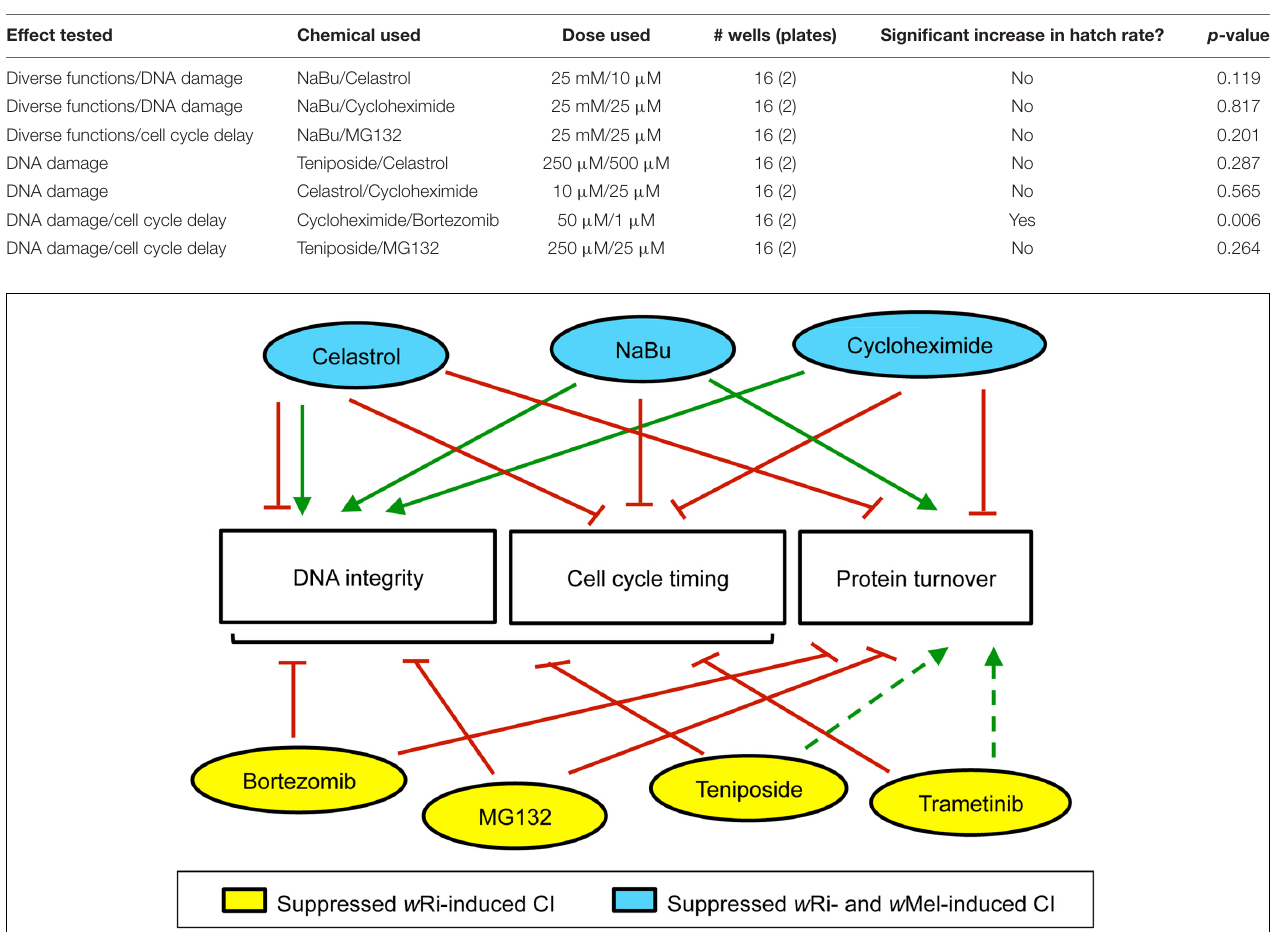
FIGURE 5 | Summary of maternal impacts that significantly increased D. simulans CI hatch rates. This information is based upon available literature, summarized in Additional File S3. Green arrows: positive impact. Red lines: negative effect. Dotted lines: interpretation based upon partial datasets. Bracket: includes multiple